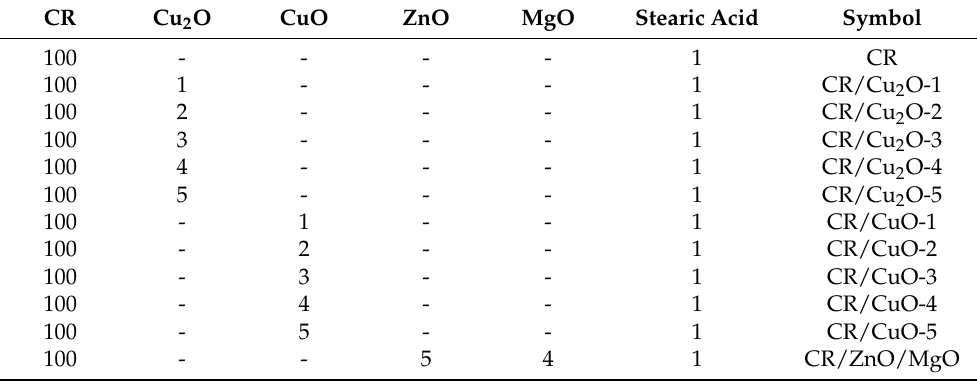
Table 1. Tested compositions and their